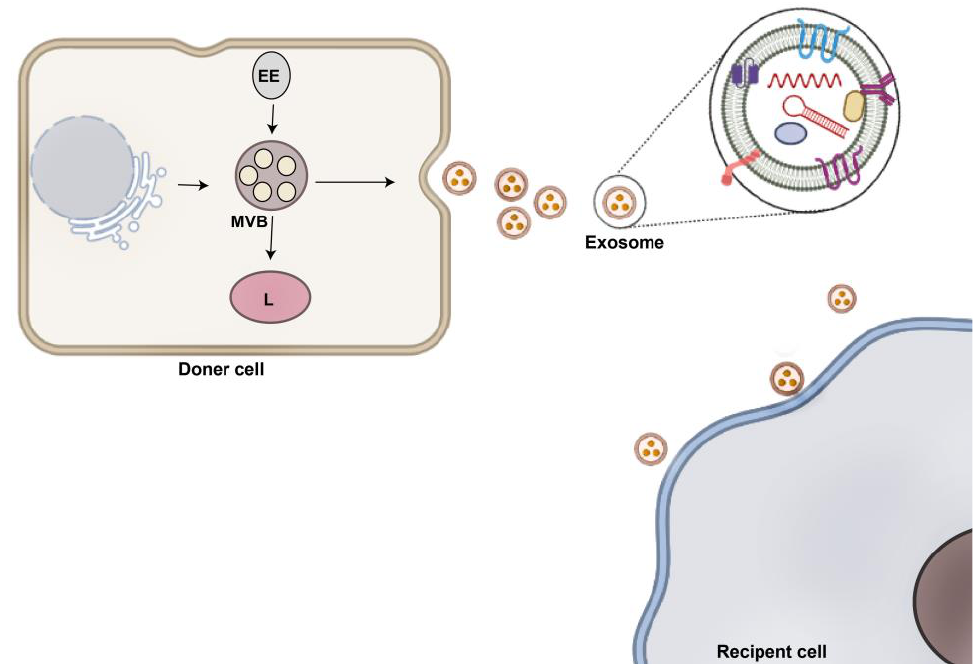
Figure 1. Biogenesis and secretion of exosomes. Many cells produce exosomes within multivesicular bodies (MVBs) via a complex mechanism. MVBs (a type of late endosomes) can fuse with the plasma membrane and secrete exosomes into the extracellular matrix. Now, exosomes can reach recipient cells located nearby or far from, inducing alteration in cell signaling. EE: early endosomes, L: lyso- some.